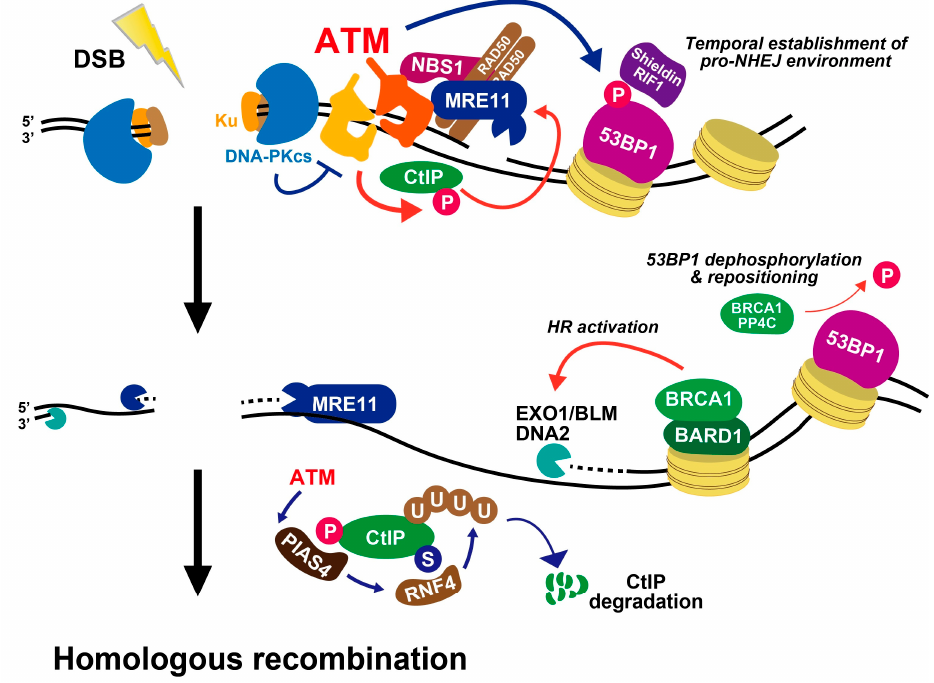
Figure 4. Roles of ATM during DSB end resection in G2 phase. See the text for